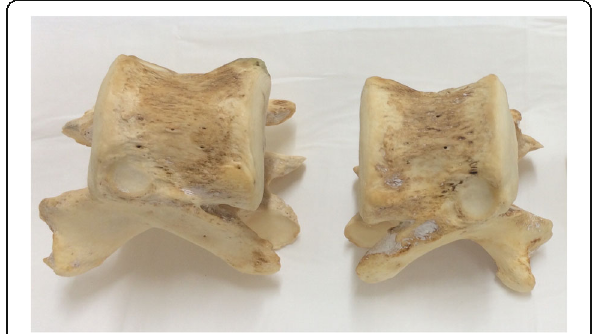
Fig. 1 Examples of dry tiger vertebral bones used as ex vivo